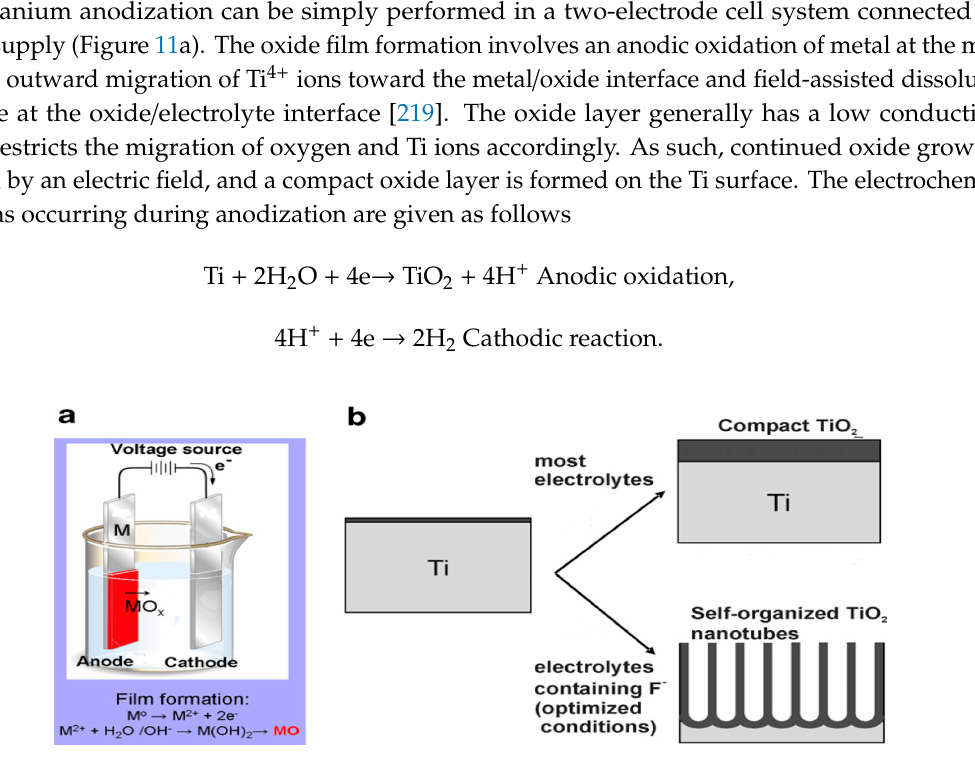
Figure 11. Schematic illustration displaying ( a ) the set-up for anodization and ( b ) frmation of compact titania layer on the Ti substrate in electrolytes without fluoride, and self-organized titania nanotube arrays in electrolytes with fluoride. Reproduced with permission from [222]. Copyright Elsevier, 2007. To form TNTs on Ti foil substrate, aqueous fluoride-containing electrolytes such